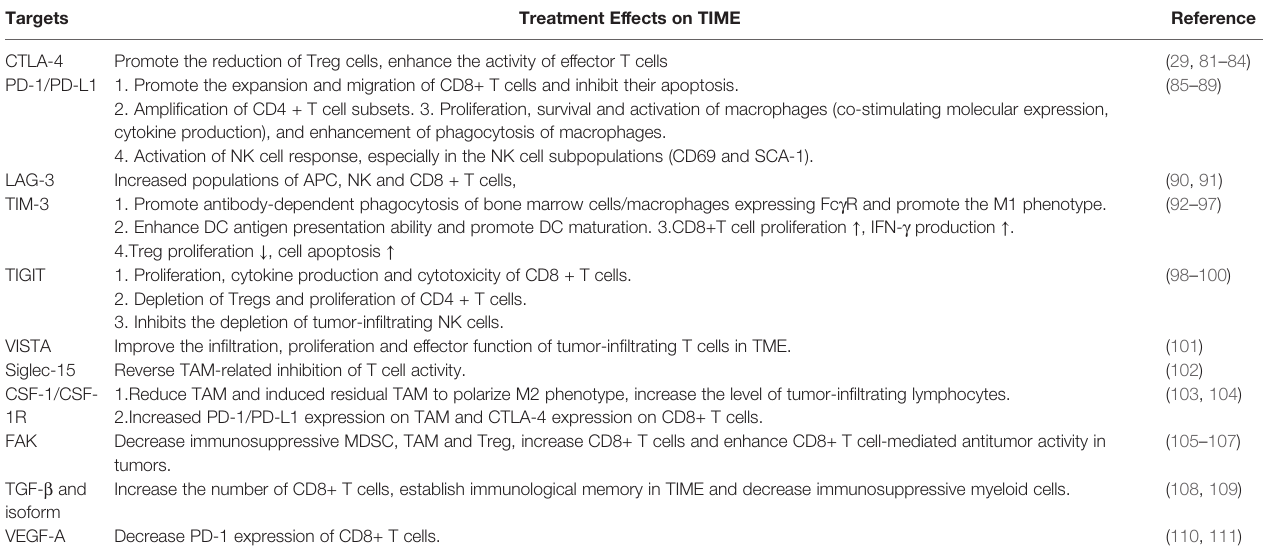
TABLE 1 | Immunotherapy targets within TIME and the treatment